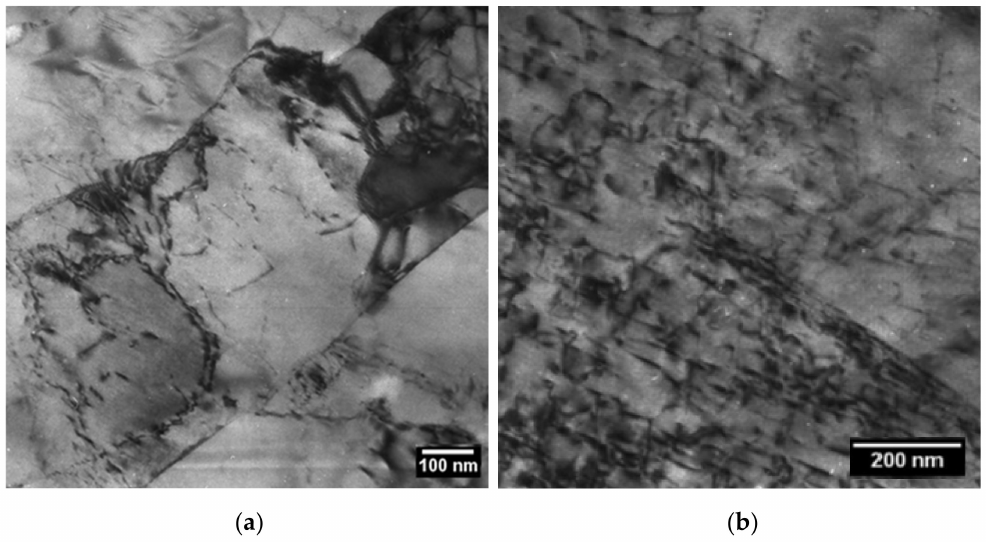
Figure 4. ( a ) Subgrain boundaries and ( b ) internal dislocations in condition 1 (N + T).